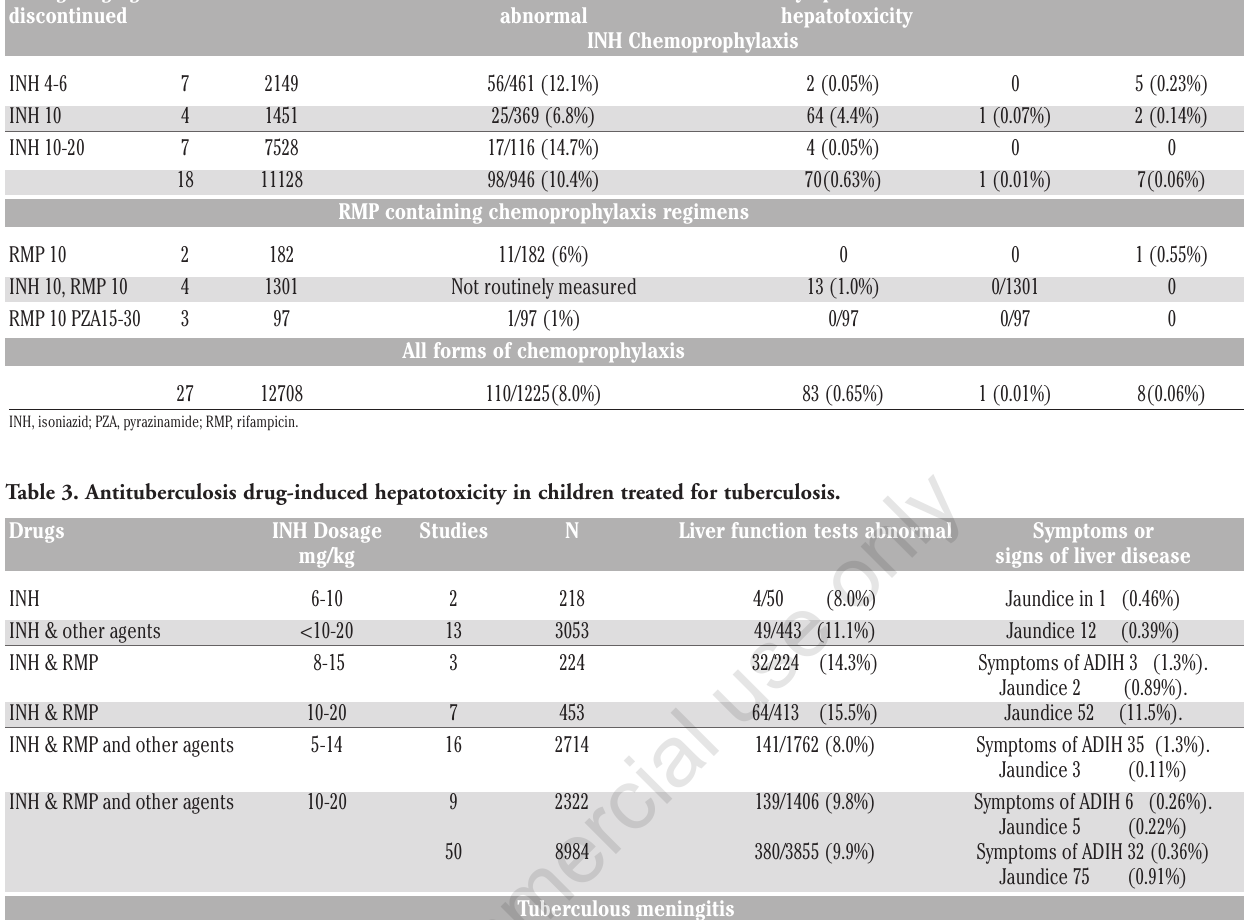
Table 2. Antituberculosis drug-induced hepatotoxicity in children receiving chemoprophylaxis. Dosage mg/kg Studies